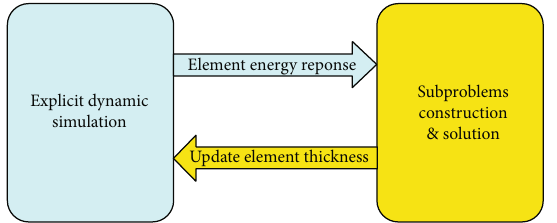
Figure 2: The basic principle of the TFD